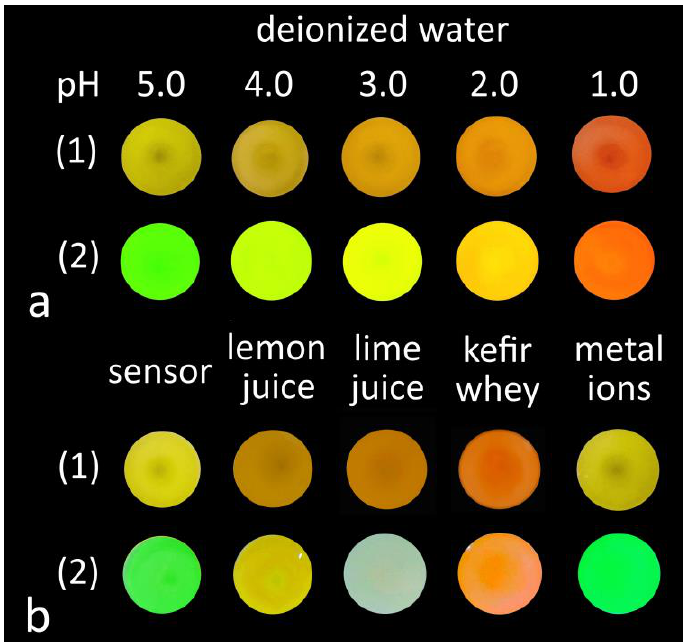
Figure 3. pH-induced color changes of polymer films based on QC1 ( 1 ) in daylight and ( 2 ) under irradiation by LED ( λ = 365 nm) for ( a ) deionized water with different pH values and ( b ) for 3 real-life samples: lemon juice (pH = 2.45), lime juice (pH = 1.95), kefir whey (acidified to pH 1.20), and an aqueous solution with pH 4.52 and containing metal perchlorates (0.1 mM of 14 salts).